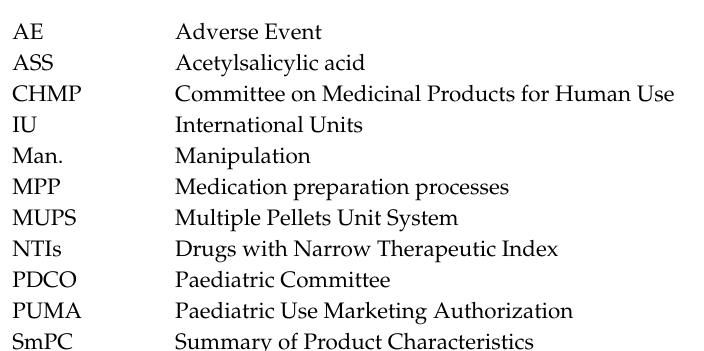
Table S1: Examples of active substances manipulated in this study categorised according to licensing status and